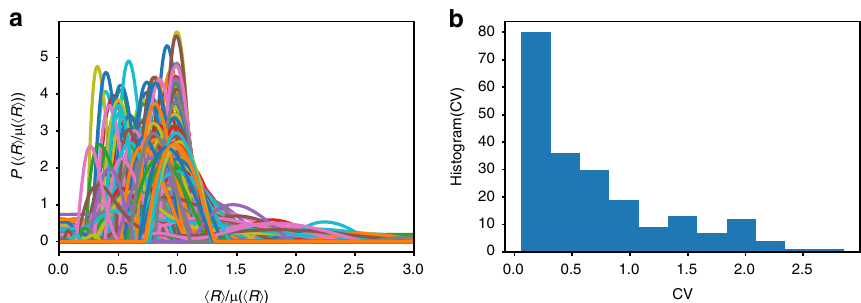
Fig. 6 Chromosome conformations are extensively heterogeneous. a Normalized distribution P ( 〈 R 〉 / μ ( 〈 R 〉 )) ( μ ( 〈 R 〉 ) is the mean of 〈 R 〉 ) for all the 212 pairs of loci reported in ref. 19 . For almost every pair of loci, the associated P ( 〈 R 〉 / μ ( 〈 R 〉 )) has multiple peaks, and is widespread. b Histogram of the coef fi cient of variations CV for all 212 pairs of loci probed in ref. 19 . The CV values are calculated for each pair of loci, using CV = σ ( 〈 R 〉 )/ μ ( 〈 R 〉 ), where σ ( 〈 R 〉 ) is the standard deviation of 〈 R 〉 . For a large number of loci pairs, CV exceeds 0.5, which is a quantitative measure of the extensive heterogeneity noted in the